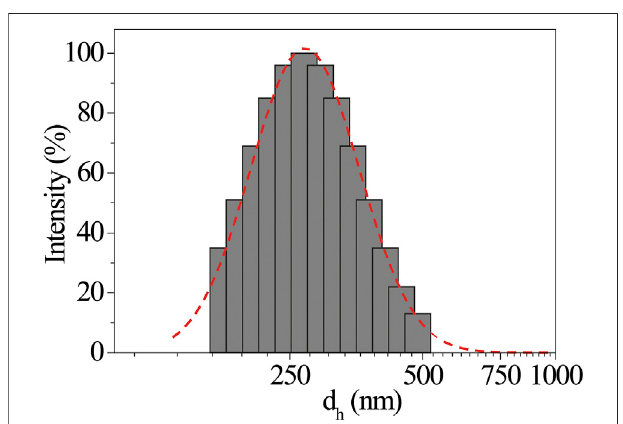
FIGURE 2 | Representative dynamic light scattering (DLS) intensity size distribution of (L)ZnP(-) 10 − 4 M toluene solution, where the presence of self assemblies is detected. Gaussian fi t in dotted